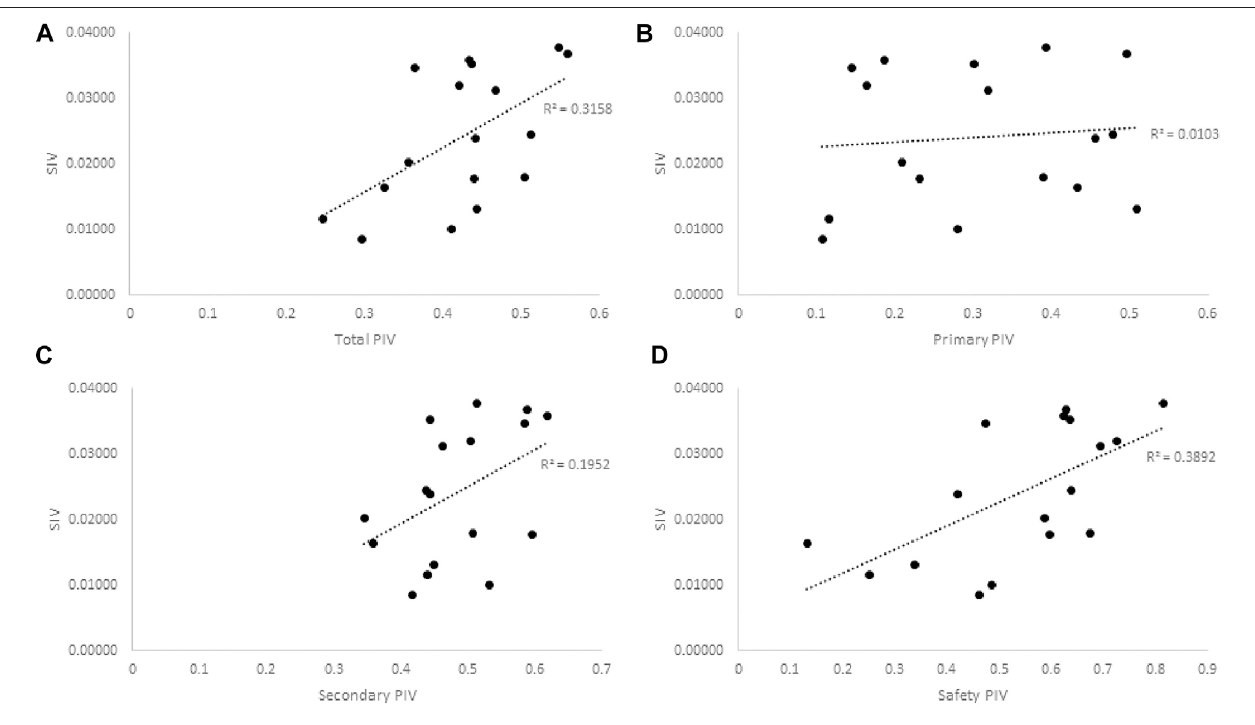
FIGURE 2 | Pearson correlation plots of the SIV and PIV of Cree medicinal plants bioactivity in (A) All assays, r 2 (cid:1) 0.3158, p (cid:1) 0.019, (B) Primary anti-diabetes Assays, r 2 (cid:1) 0.0103, p (cid:1) 0.7, (C) Secondary anti-diabetes Assays, r 2 (cid:1) 0.1952, p (cid:1) 0.076, and (D) Safety assays, r 2 (cid:1) 0.3892, p (cid:1) 0.0074. Greater SIV values indicate greater associated anti-diabetic potential based on ethnobotanical evidence. Greater PIV values indicate more signi fi cant relative activity in associated bioassays.